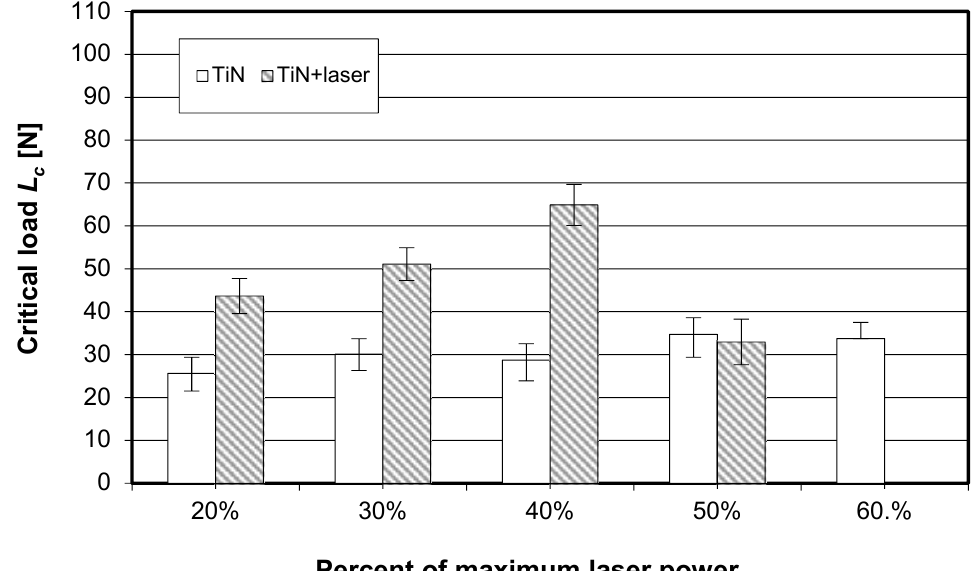
Figure 6. Impact of laser heating on the adhesion (critical load determined by scratch test) of the single-layer coating (TiN) to the SM25 sintered carbide cutting inserts (P15–P40).